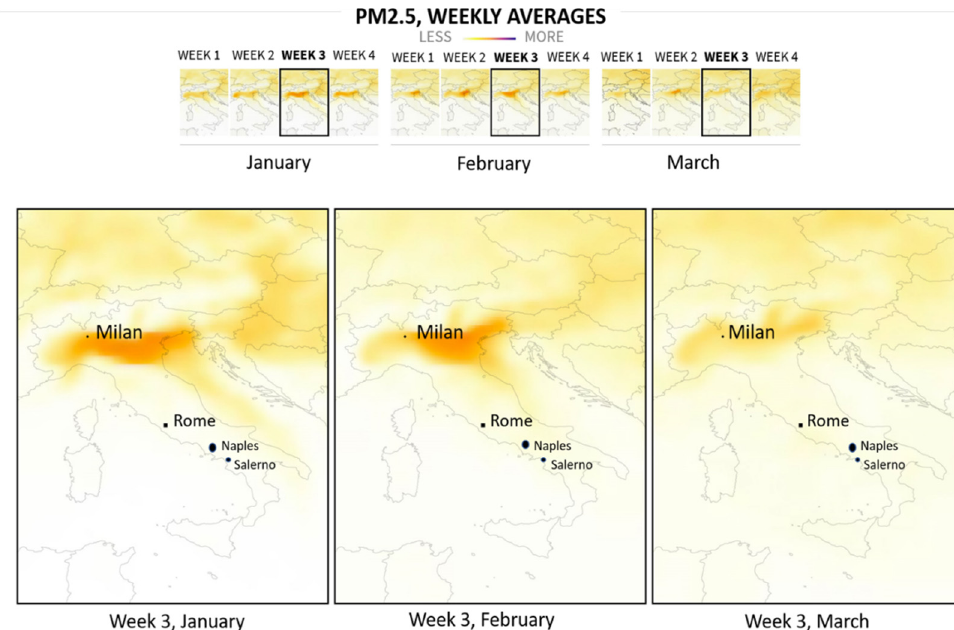
Figure 1. Levels of PM 2.5 fell in four Italian cities after the government imposed gradual re-